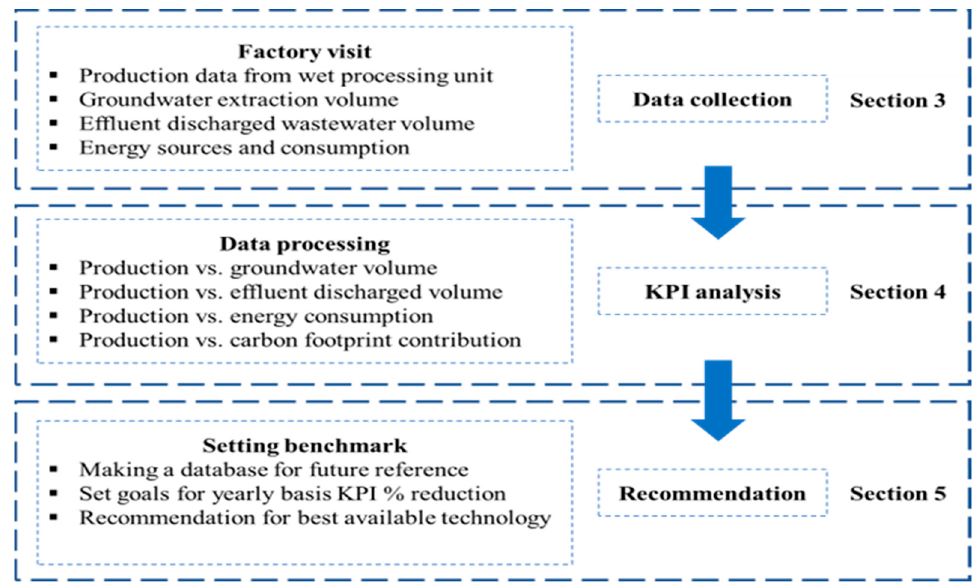
Figure 2. Work procedure of data processing and analyzing KPIs.